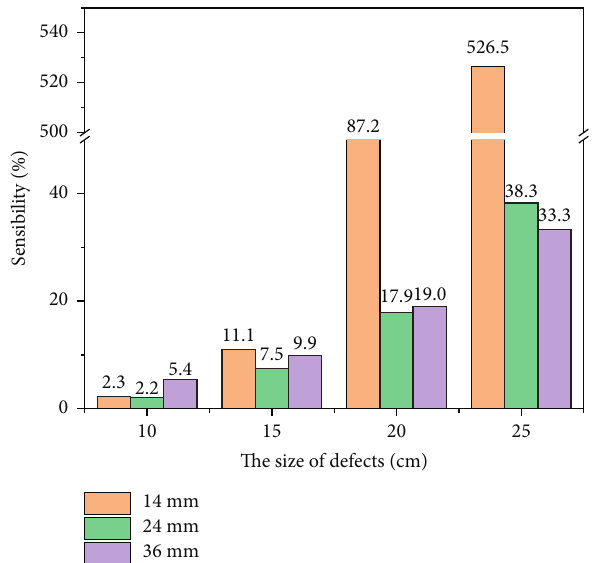
Figure 10: Response waveform frequency spectrum under dif- ferent defect